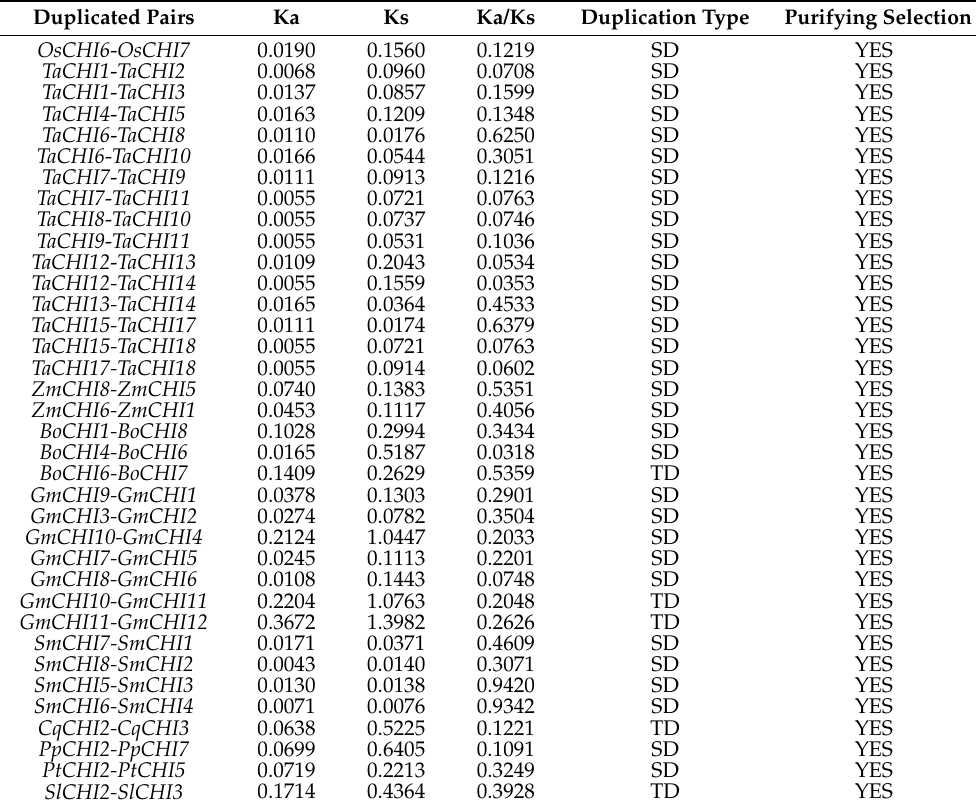
Table 2. Ka/Ks analysis for the duplicated CHI paralogs in green